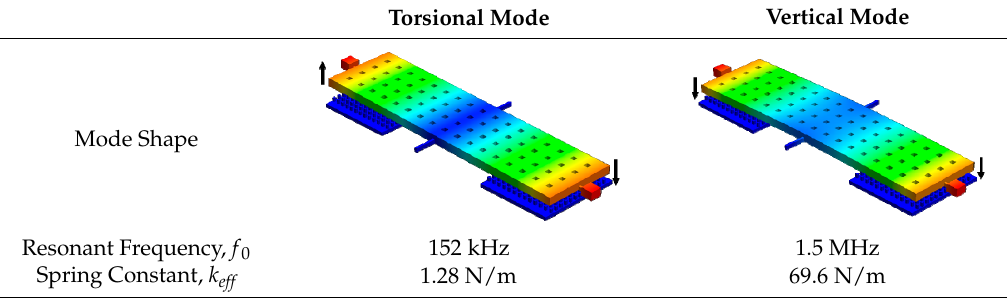
Figure 3. SEM images of the cross-section B-B’ in Figure 2c over the contact in the three different designs (contact between body relay with different composition and drain) showing before (left images) and after (right images) the releasing: ( i ) Type I, ( ii ) Type II and ( iii ) Type III. These figures can be compared with the cross-section A3-A4 at the contact area of the relay in Figure 1, in which the different composition for contact source and drain are explained. Table 2. CoventorWare simulation of the resonant frequencies and mode shapes of the seesaw relay.